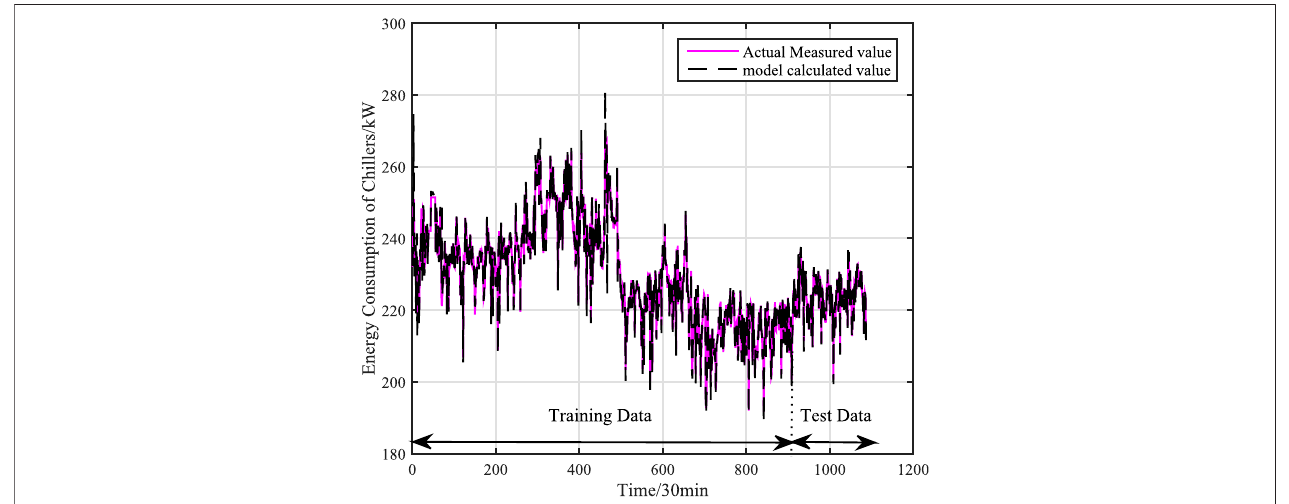
FIGURE 8 | Training and test results of adaptive hybrid model under single working condition (working condition 2).